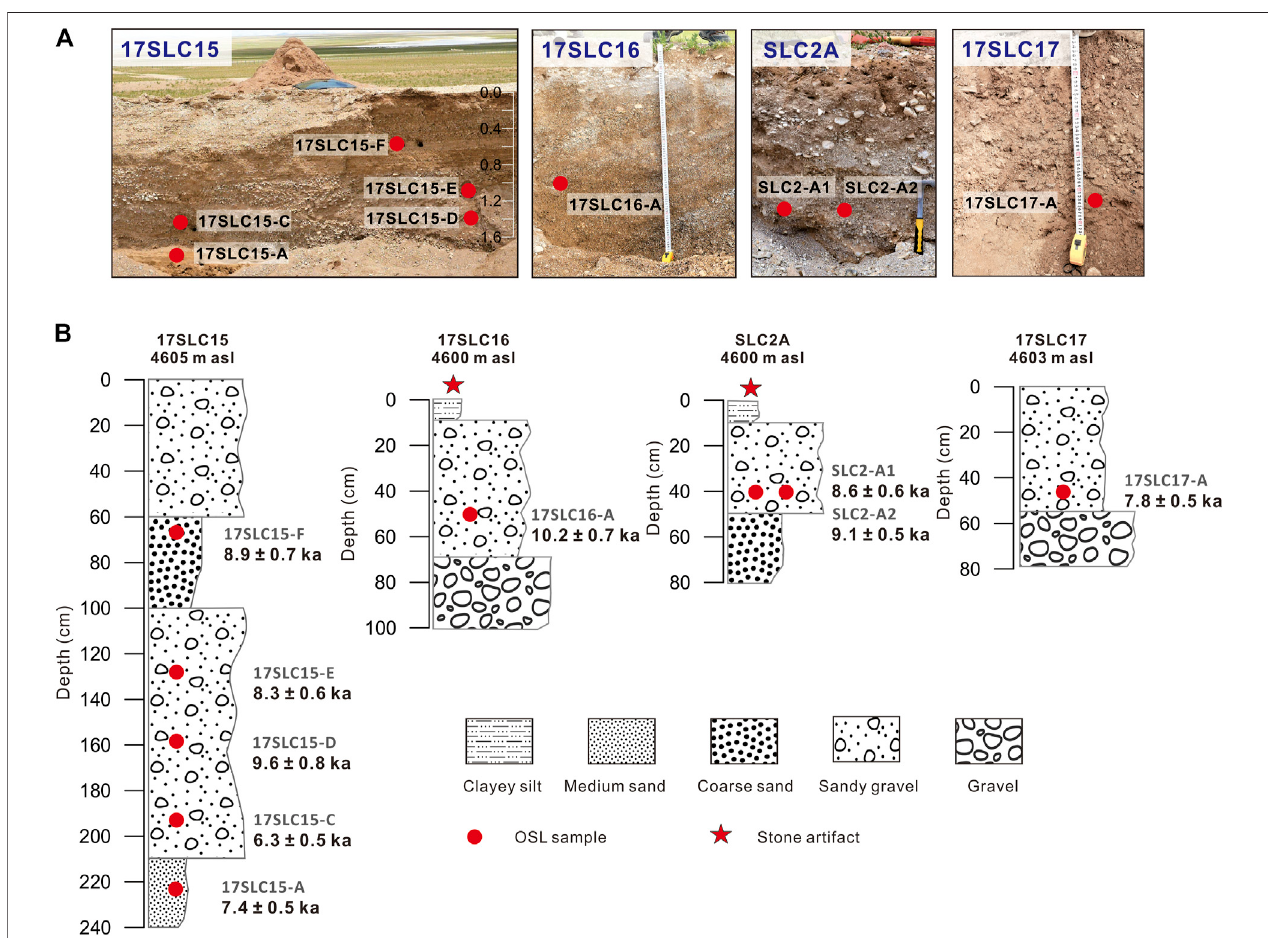
FIGURE 3 | (A) Photos showing the four studied sections and sampling positions. (B) Lithological logs of sections and OSL ages.